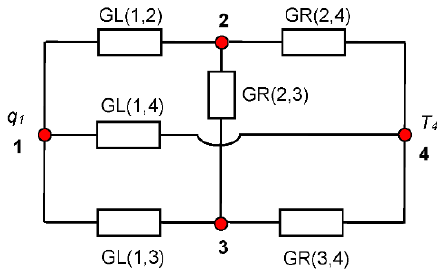
Figure 2. The 4 nodes model.